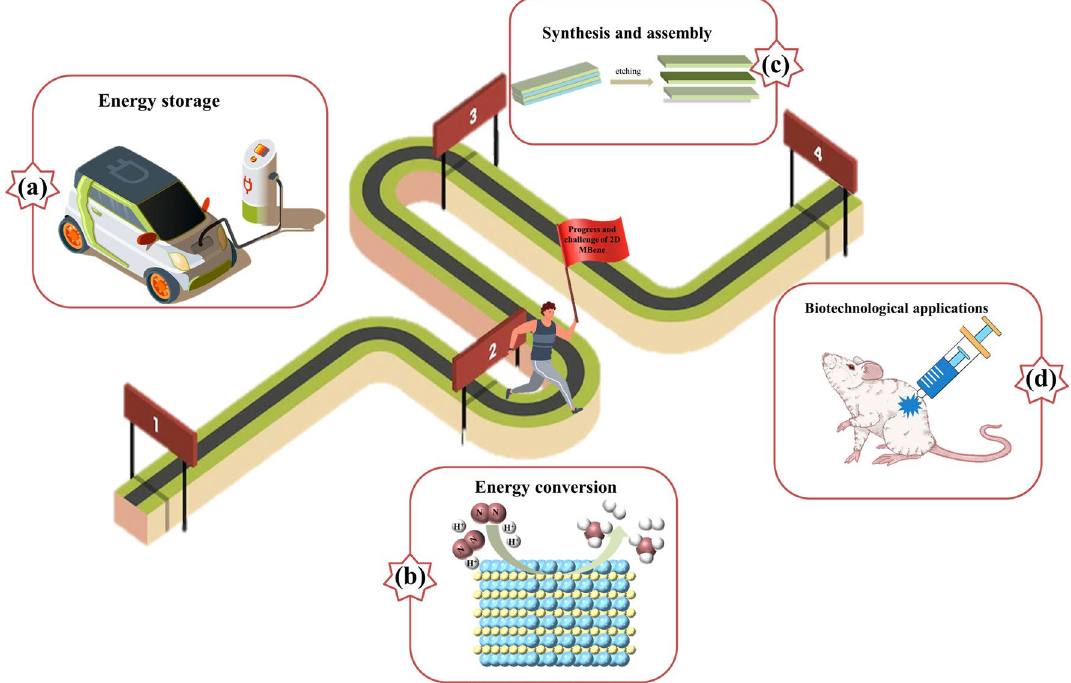
Fig. 27 Progress and challenges of 2D MBene materials. The main progress of MBenes in a energy storage and b conversion. Prospect of future application of MBenes in c synthesis and d